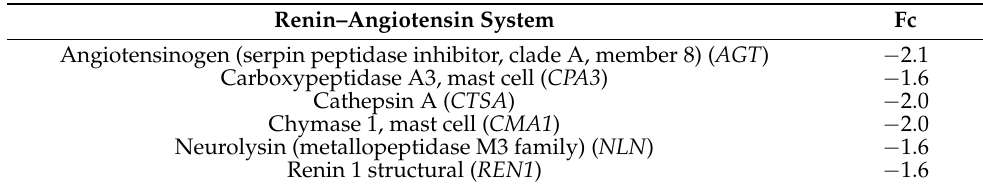
Table 5. Changes in gene expression in dogs fed the polyherbal vs. choline chloride in processes related to disease prevention and